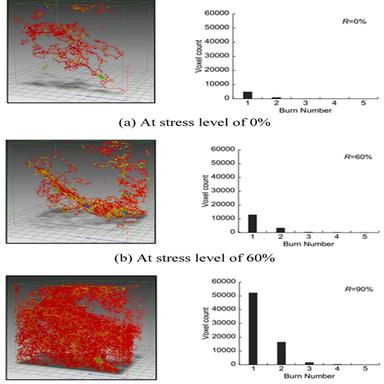
The distribution of medial axis (the warm color is a small burn number and the cold color represents a large burn number; the red color represents burn number 1) and the amount of burn number in cubic concrete specimens (10 × 10 × 10 mm3 ) under the stress level of (a) 0 %, (b) 60 % and (c) 90 % adapted from.